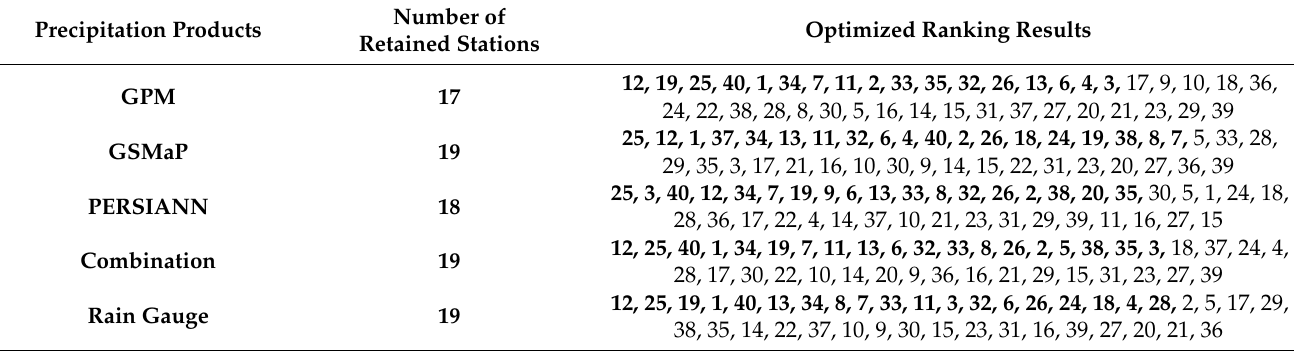
Table 1. Optimized ranking results of the 40 existing rain gauge stations in the